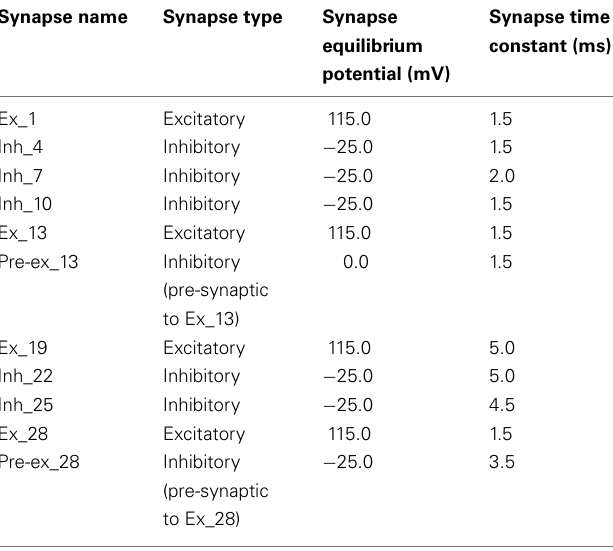
Table 3 | Synaptic parameters for the network